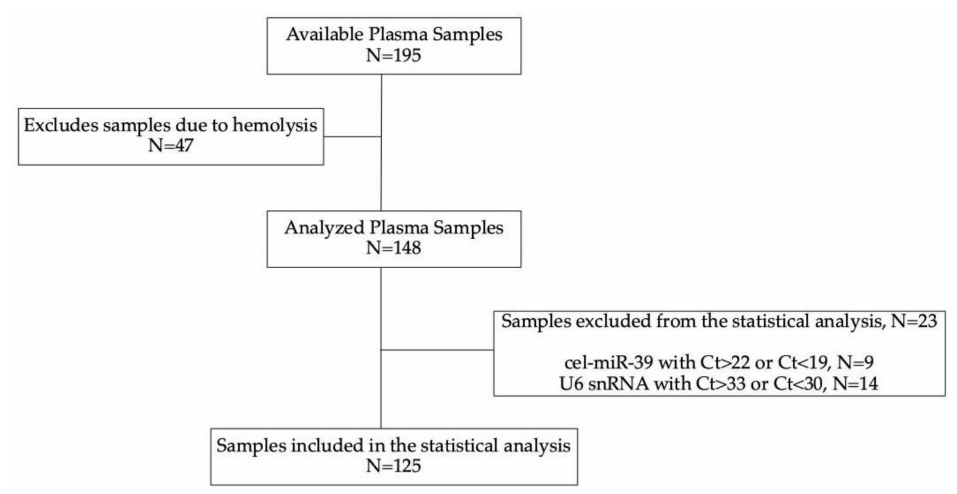
Figure 1. Flow of the study, schematic illustration.